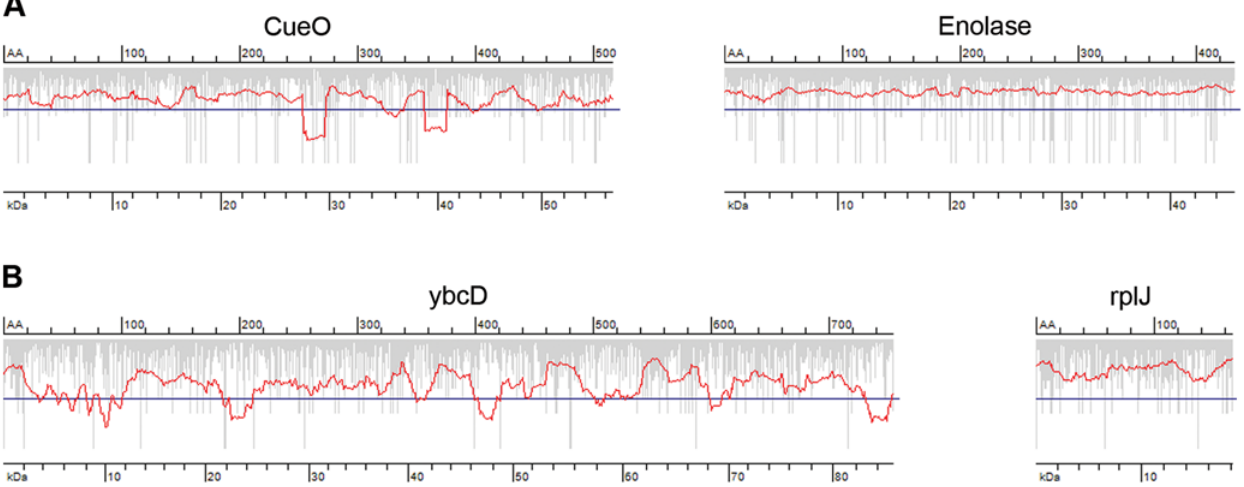
Figure 1. Prediction of the average translation rate in the ORFs. Examples of E. coli (A) and B. subtilis (B) ORFs with predicted smooth (right panels) and rough (left panels) translation profiles. Vertical gray bars represent the individual rate of a single codon; the translation rate profile (red line) is averaged from the individual rates with a window of 19 triplets, and minima below the genome-wide threshold (solid blue horizontal line) mark the putative sites for translational attenuation. AA denotes the amino acids number (upper axis) and kDa the corresponding molecular weight in kDa (lower axis) on the translation profile plots.